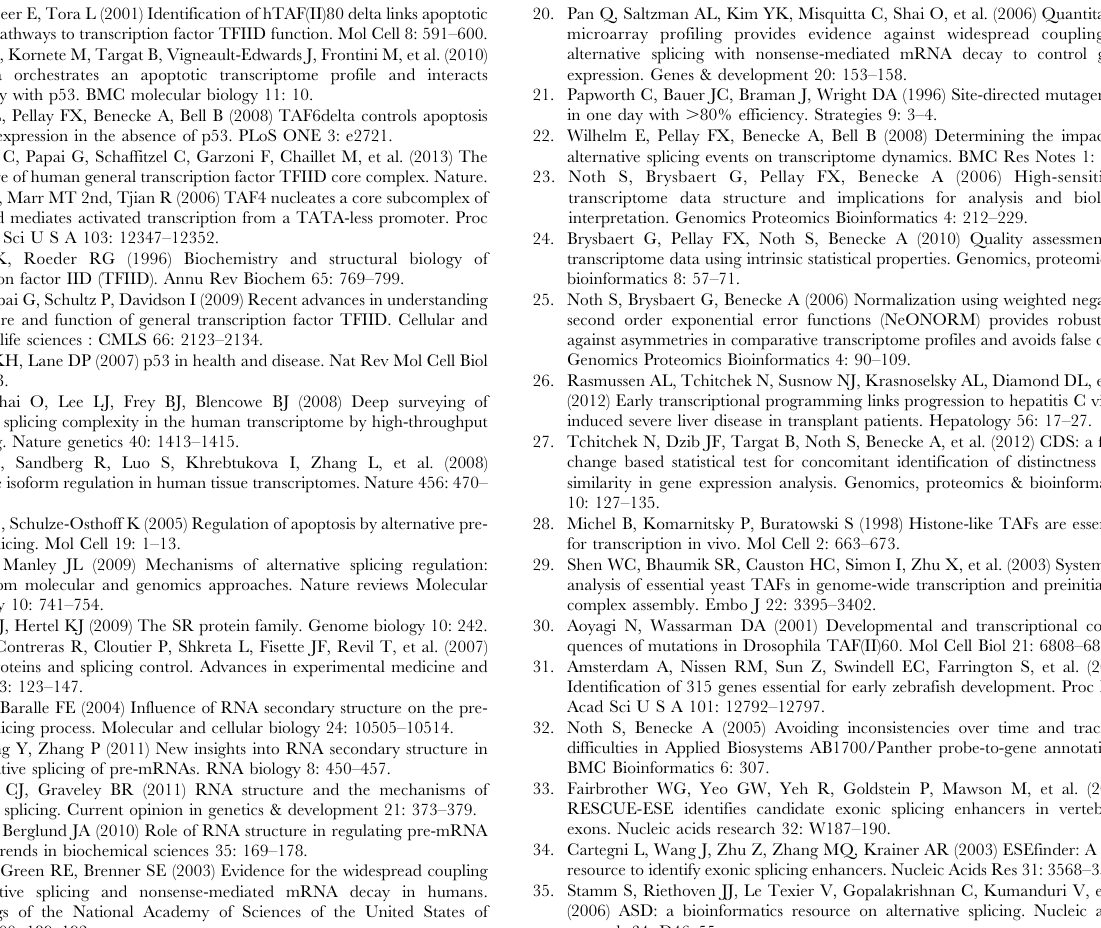
Table S1 List of synthetic oligonucleotides used in this study. The names of mutations are given in the left column and the oligonucleotide sequence is listed in the right